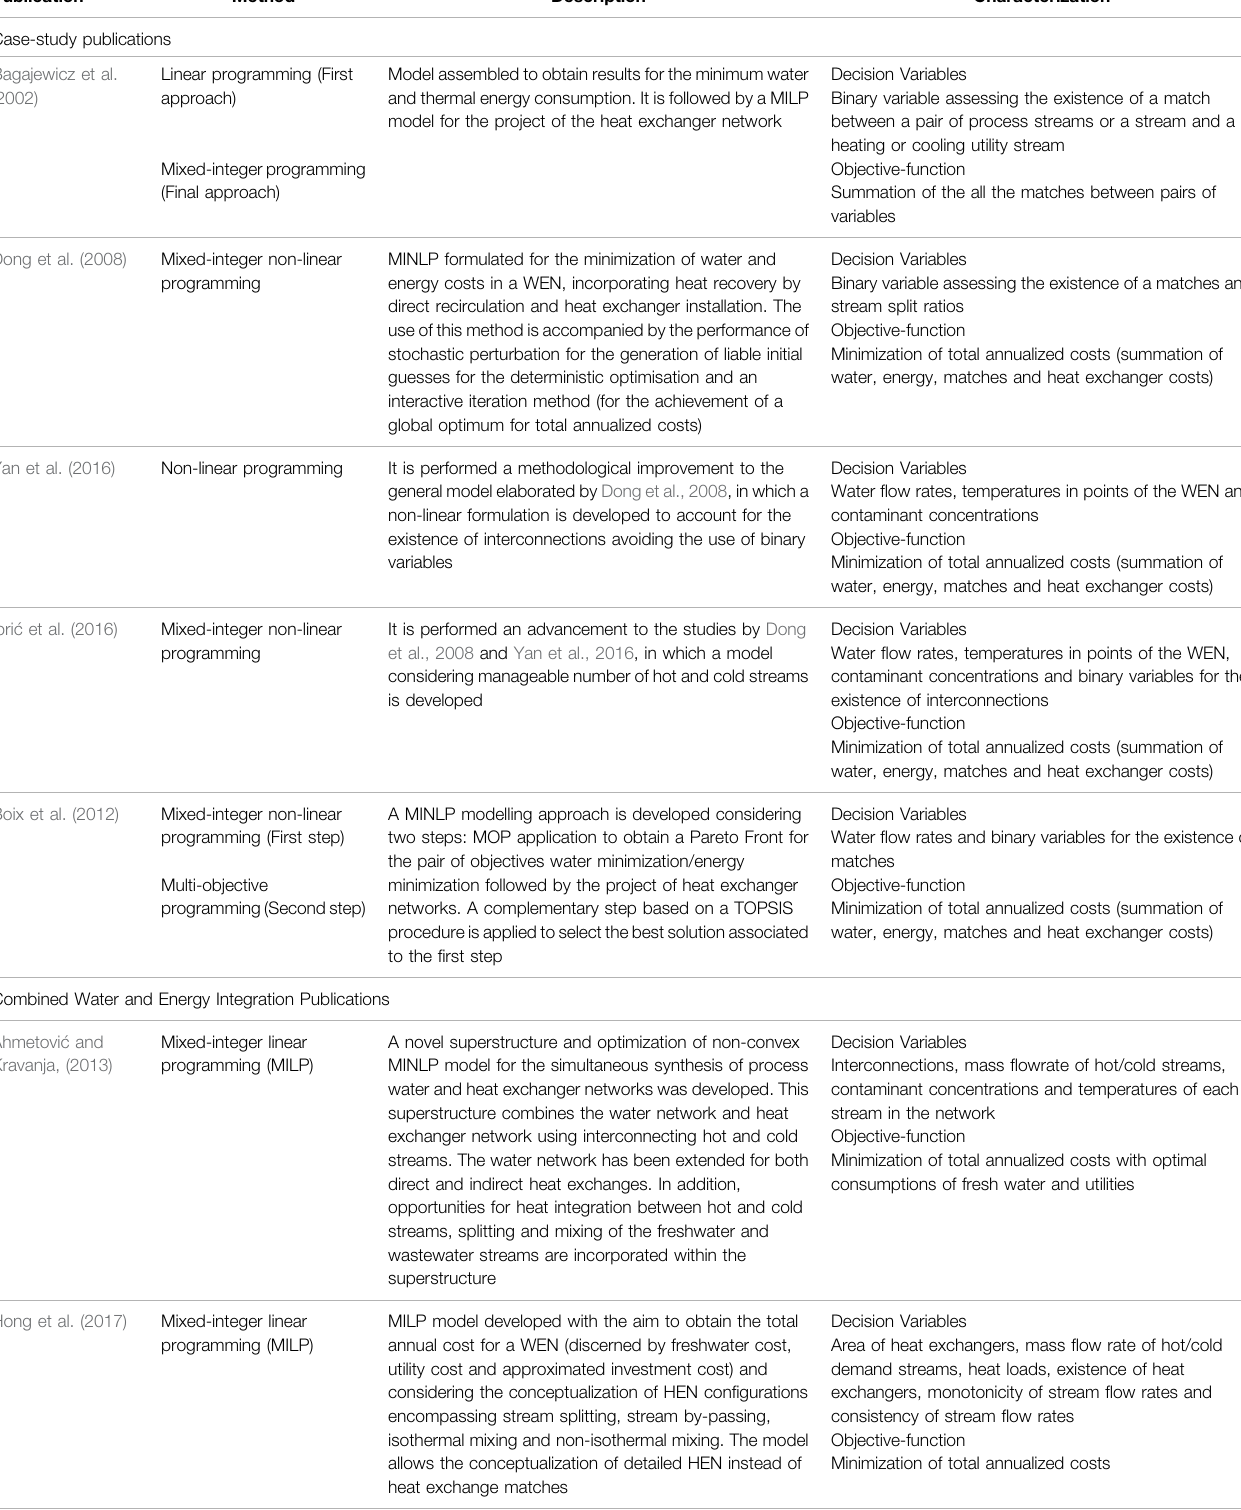
TABLE 1 | Brief Description of previous